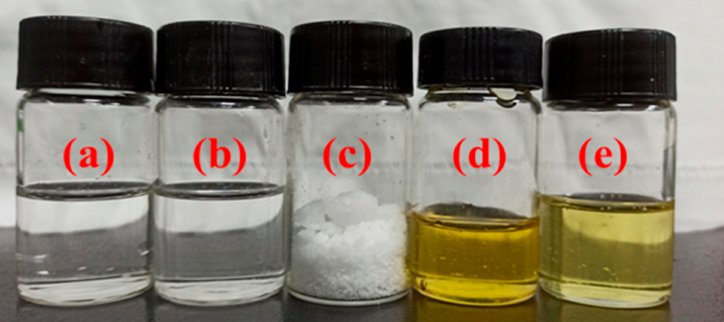
Figure 1. A photo of raw materials and TBPBP: ( a ) glutaric dialdehyde, ( b ) diethyl phosphite, ( c ) diisopropanolamine, ( d ) intermediate, ( e ) TBPBP.